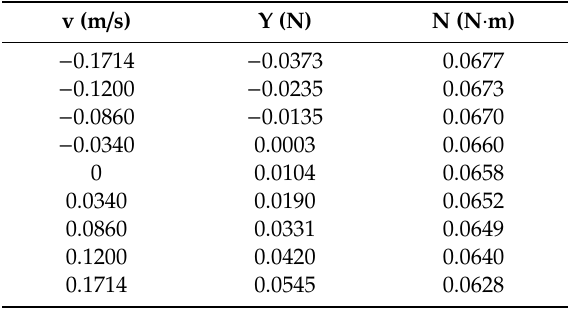
Table 4. Measurements of vertical force Y and pitching moment N at di ff erent linear velocity